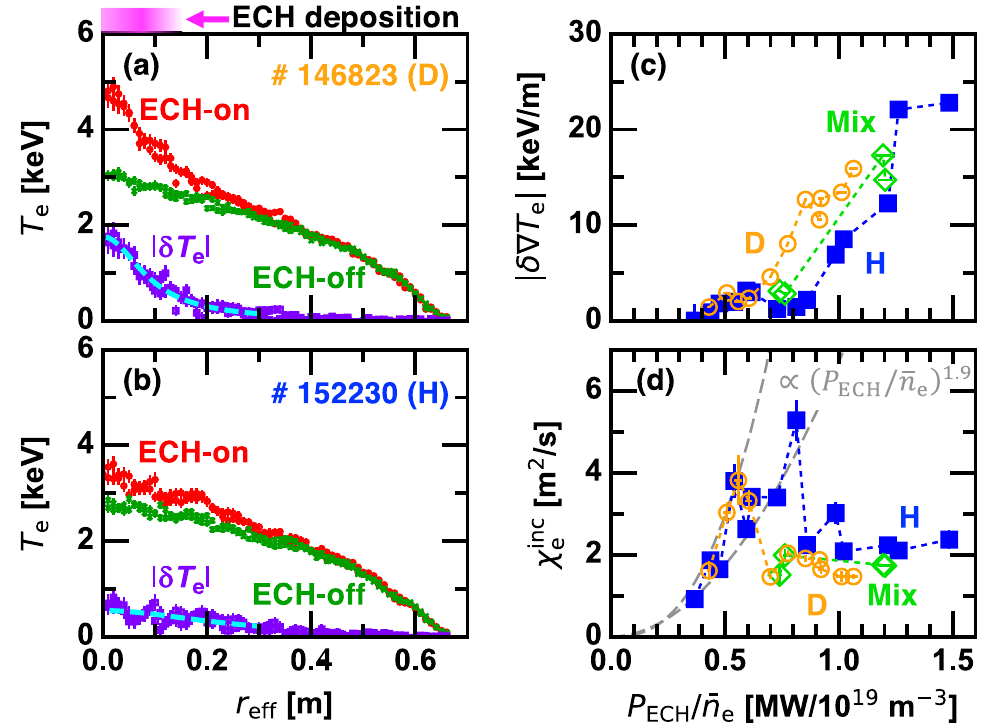
Figure 1. Radial profiles of the electron temperature when the ECH is applied and not applied for ( a ) deuterium plasmas and ( b ) hydrogen plasmas; ( c ) the peak-to-peak modulation amplitude of the electron temperature gradient and ( d ) the incremental heat diffusivity as a function of the applied ECH power normalized by the line averaged density. Magnitude of the profile variation | δ T e | defined as difference between the ECH-on and ECH-off profiles is plotted by purple symbols with the Lorentzian fit in ( a ) and ( b